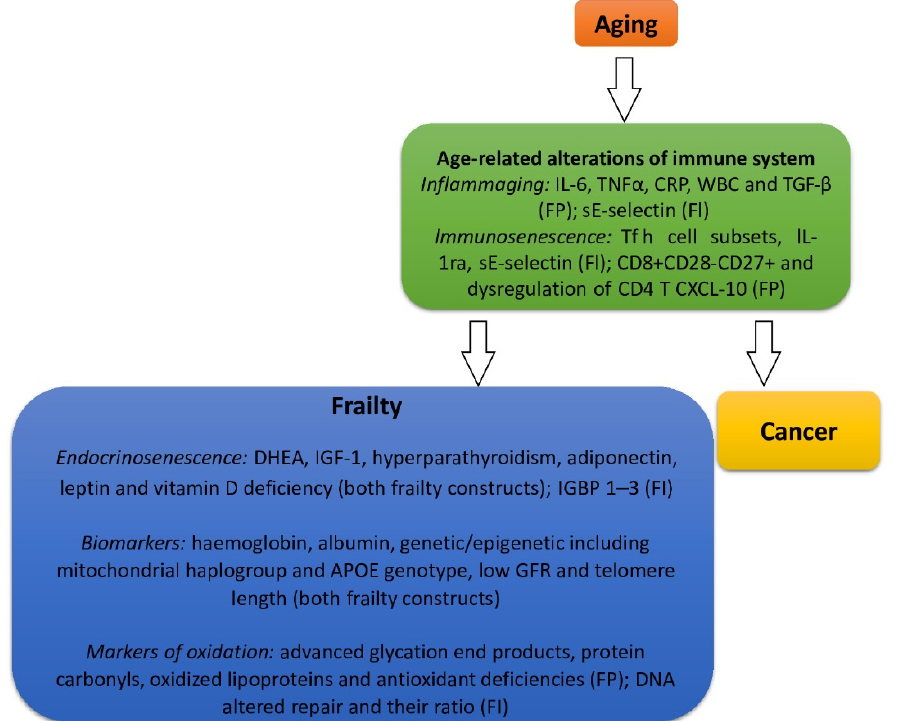
Figure 2. Bidirectional interplay among biological aging, the moderating role of inflammaging and immunosenescence, and frailty biomarkers on the basis of the conceptual frailty framework of the physical frailty phenotype of Fried (FP) or the deficit accumulation model of Rockwood (FI). Interleukin 6 (IL-6), tumor necrosis factor- α (TNF- α ), C-reactive protein (CRP) and white blood cells (WBCs), T follicular helper cell (Tfh cell) subsets, interleukin-1 receptor antagonist (IL-1Ra), soluble endothelial leukocyte adhesion molecule-1 (sE-selectin), C-X-C motif chemokine ligand 10 (CXCL10), transforming growth factor- β (TGF- β ), dehydroepiandrosterone (DHEA), insulin-like growth factor-1 (IGF-1), insulin-like growth factor binding protein1–3 (IGFBP 1–3), and glomerular filtration rate (GFR).